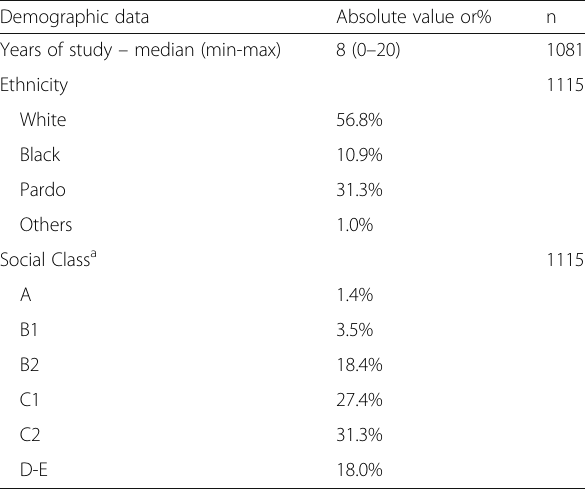
Table 1 Demographic data of patients with rheumatoid